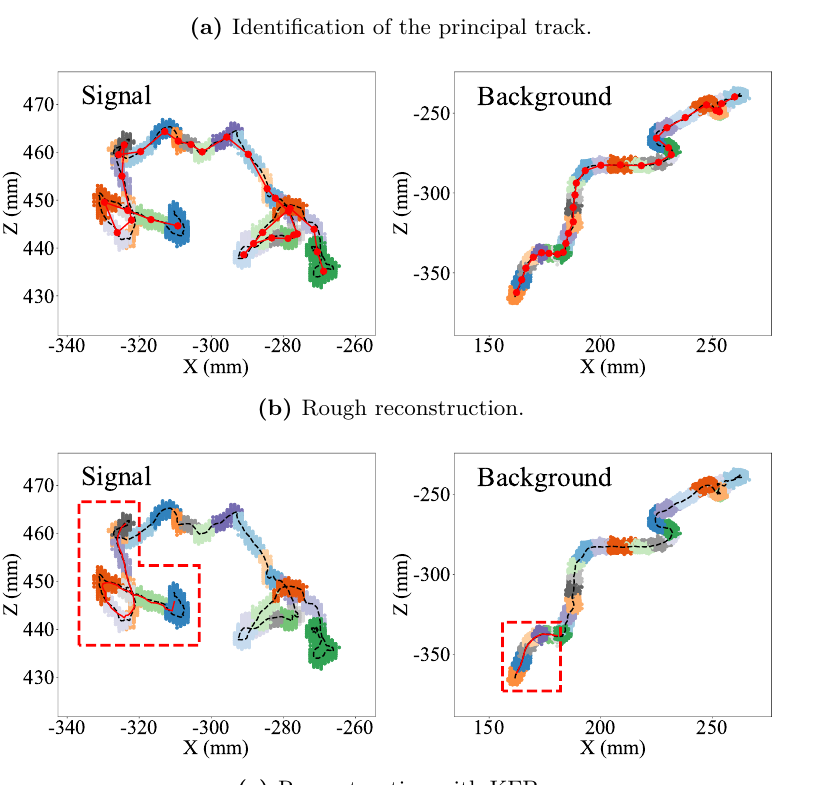
Figure 2. Track reconstruction procedures of simulated 0 νββ signal (left side) and background (right side) events, including (a) identification of the principal track, (b) rough reconstruction, and (c) reconstruction with KFB, respectively. The tracks are projected in the XZ plane, where X is one of the transverse directions and Z is the longitudinal direction along the field lines in a TPC. The MC-truth track from Geant4 (black dashed lines), simulated readout hits (orange points), Birch clustering hits (multi-colored points), BCs (red dot dash lines), and the reconstructed tracks by the ends (red lines) are labeled. We filter on both sides of the track, but one of the filter result is drawn for illustration. KFB stops at the BCs on each